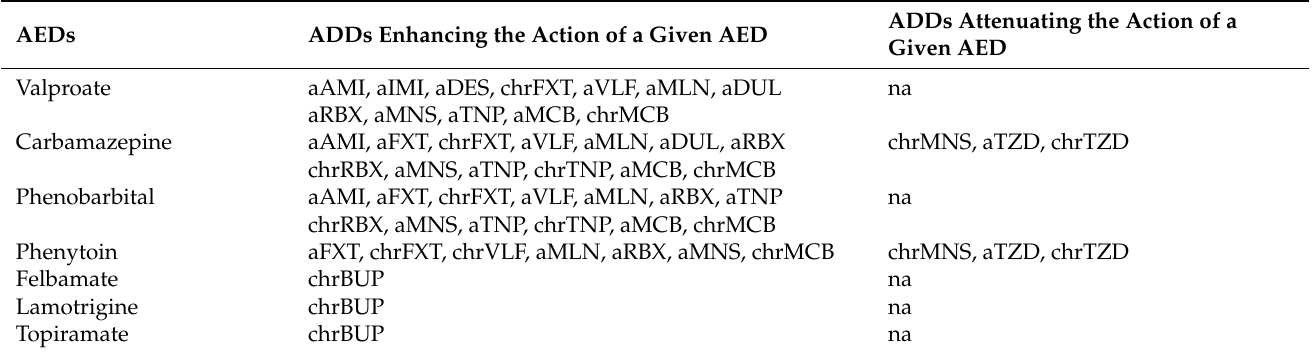
Table 2. Effects of antidepressant drugs on the antielectroshock action of individual antiepileptic drugs. AEDs ADDs Enhancing the Action of a Given AED